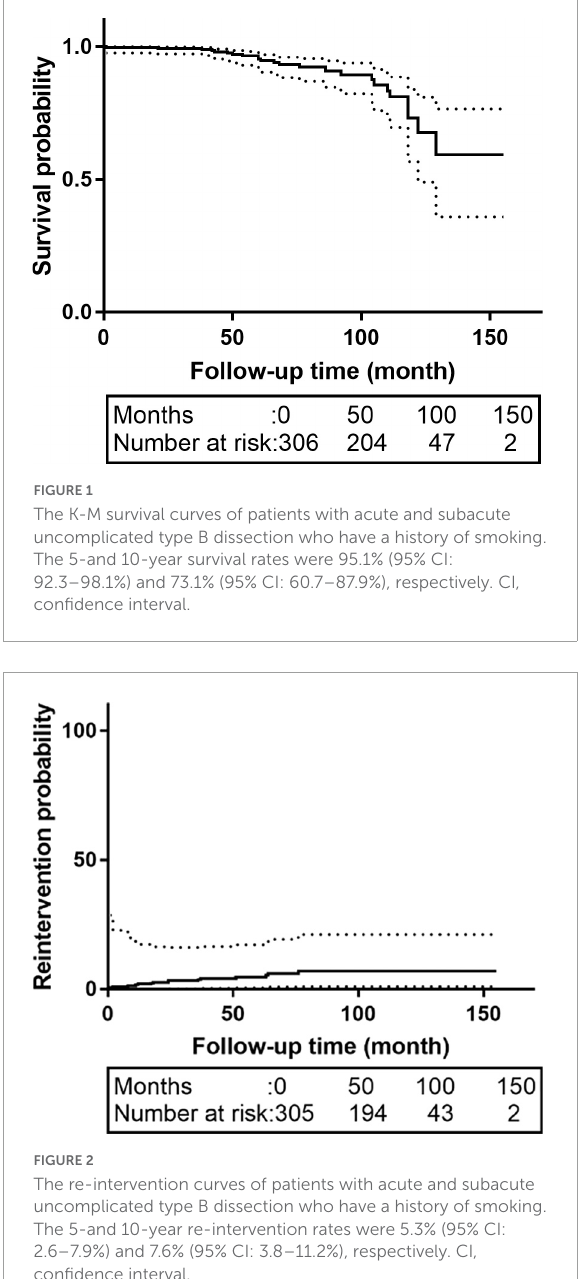
FIGURE2 The re-intervention curves of patients with acute and subacute uncomplicated type B dissection who have a history of smoking. The 5-and 10-year re-intervention rates were 5.3% (95% CI: 2.6–7.9%) and 7.6% (95% CI: 3.8–11.2%), respectively. CI, confidence interval.